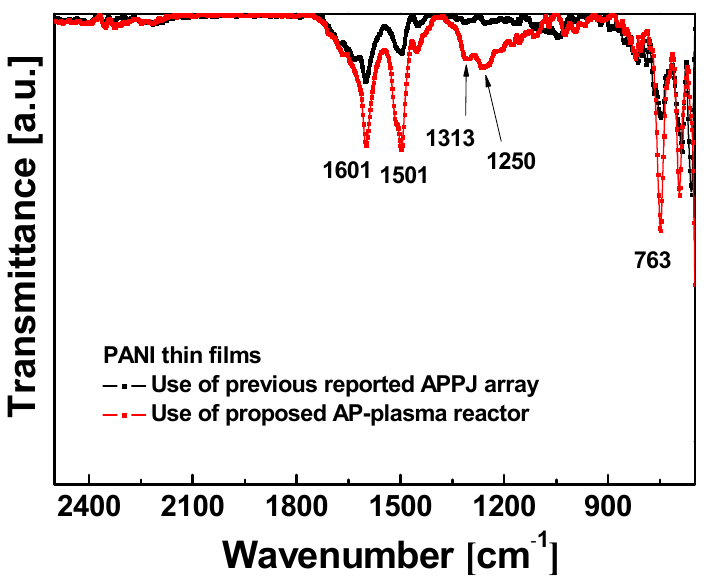
Figure 8. Comparison of the FT-IR spectra of the PANI thin films fabricated using the newly designed AP-plasma reactor (red line) and the previously reported APPJ array (black line).